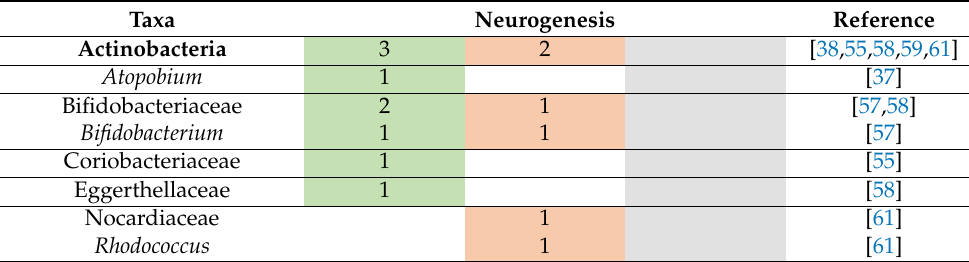
Table 9. Actinobacteria and